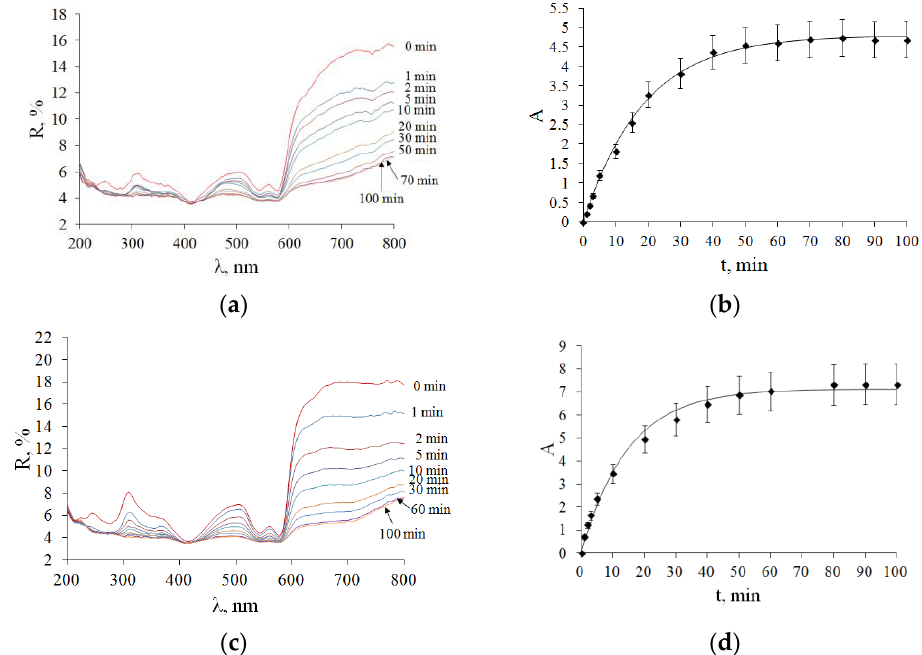
Figure 9. DRSs of cat ovarian tissue samples during 99.5% glycerol immersion. The corresponding kinetics of the difference in effective optical densities at the current and initial time ∆ A ( t , λ ) were recorded at 600, 700 and 800 nm and then averaged (see Equation (1)) of the studied ovarian samples during the application of glycerol. The symbols represent the experimental data, and the solid curves represent the corresponding approximation of the experimental data within the framework of the free diffusion model; ( a , b ) F-ph; ( c , d ) L-ph.